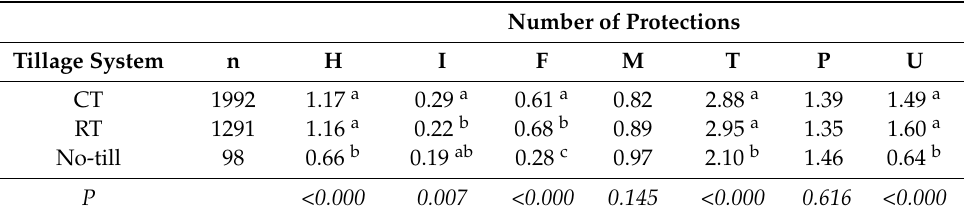
Table A10. Number of chemical protections of evaluated tillage systems; average of years 2002–2010 and eleven crops.